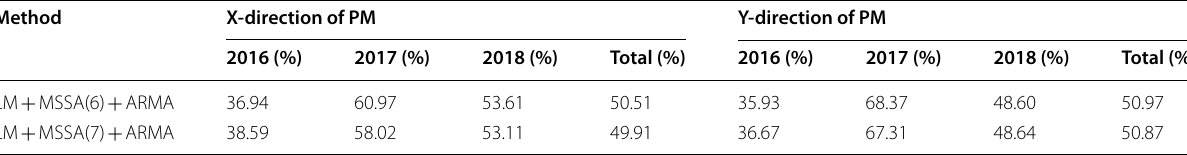
Table 4 Improvement rate of various models in the X- and Y-directions of PM Method X‑direction of PM Y‑direction of